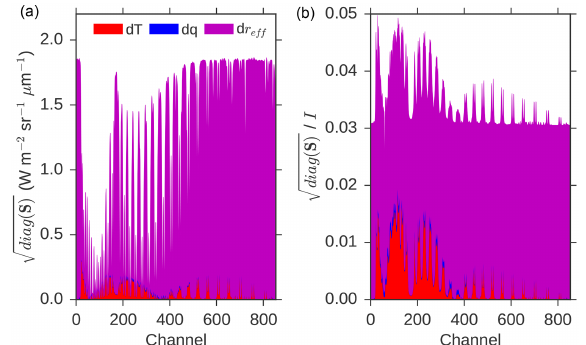
Figure 1. Square root of diagonal components of the covariance ma- trix, stacked contribution from temperature (red), humidity (blue) and effective radius (magenta). Results shown for a cloud with τ = 10 and P top = 850hPa. (a) Value in absolute radiance; (b) the same covariance values as a fraction of the unperturbed absolute radiance in the appropriate channel, such that 0.03 represents an uncertainty of ±